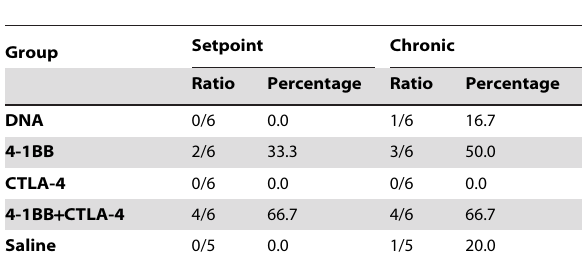
Table 2. Animals with Complete Viral